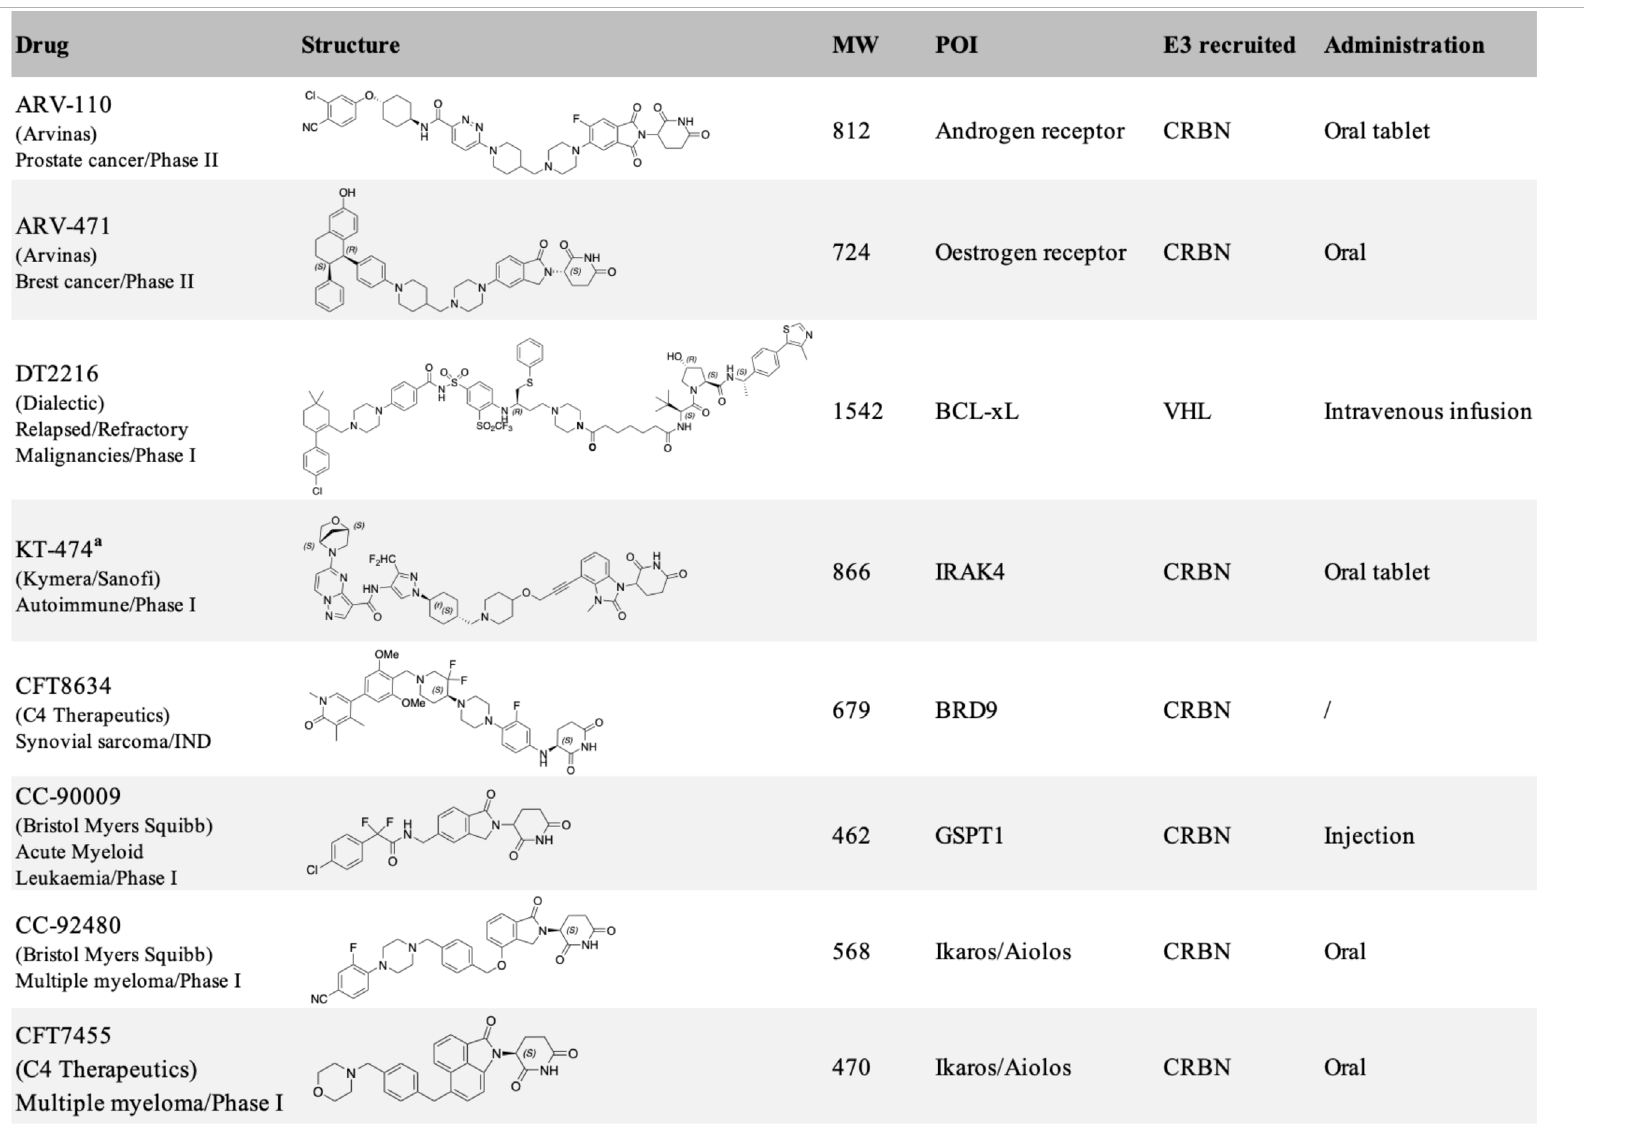
TABLE 1 | Protein degraders approaching clinical trial (https://clinicaltrials.gov/) with structures